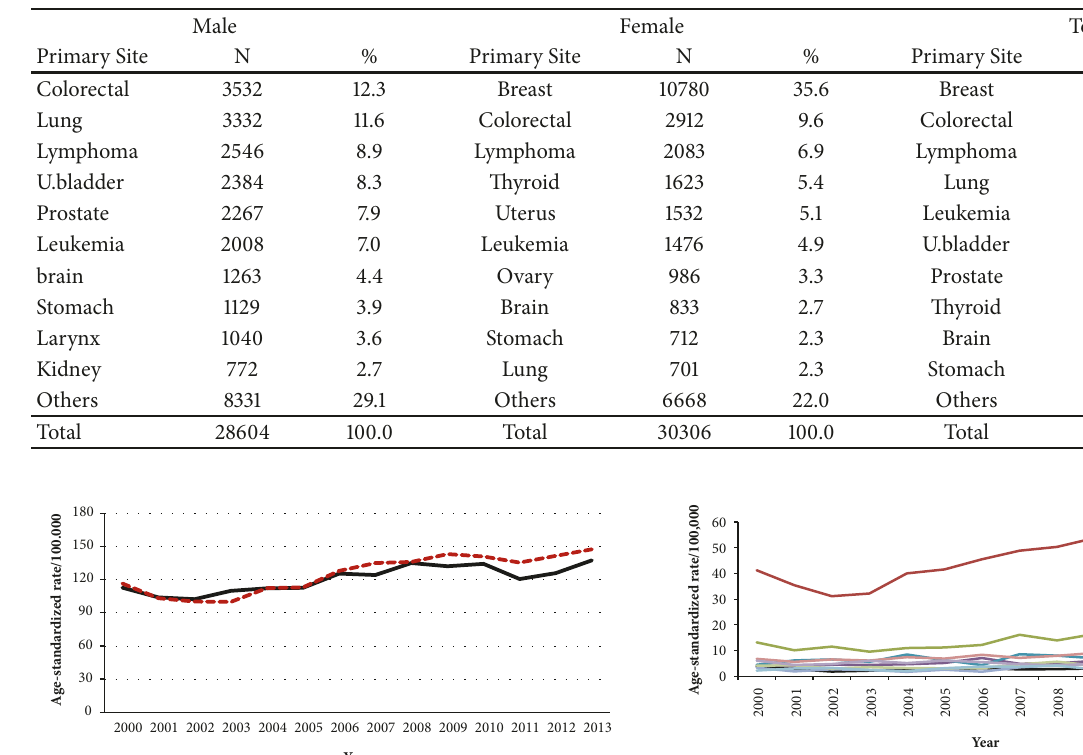
Table 3: The cumulative top ten cancers in males and females, Jordan, 2000-2013.